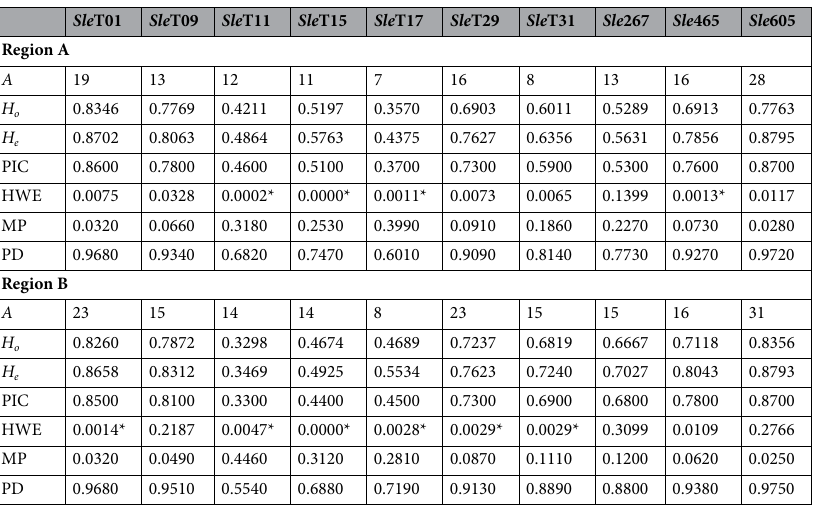
Table 1. Genetic diversity and forensic variables ( A : total number of alleles; H o : observed heterozygosity; H e : expected heterozygosity; PIC: polymorphic information content; HWE: Hardy–Weinberg equilibrium; MP: matching probability; PD: power of discrimination) for each the 10 SSR loci of Shorea leprosula in the Region A and B databases. *Significant deviations from HWE after Bonferroni adjustment ( P < 0.05/10 =